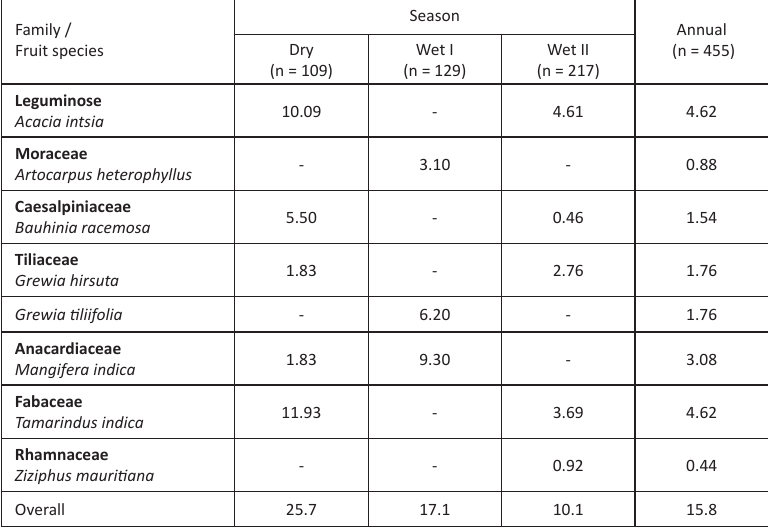
Table 1. Percent frequency occurrence of various species of fruits with respect to the total number of elephant dung piles sampled in different seasons in Nilgiri Biosphere Reserve, southern India Family / Fruit